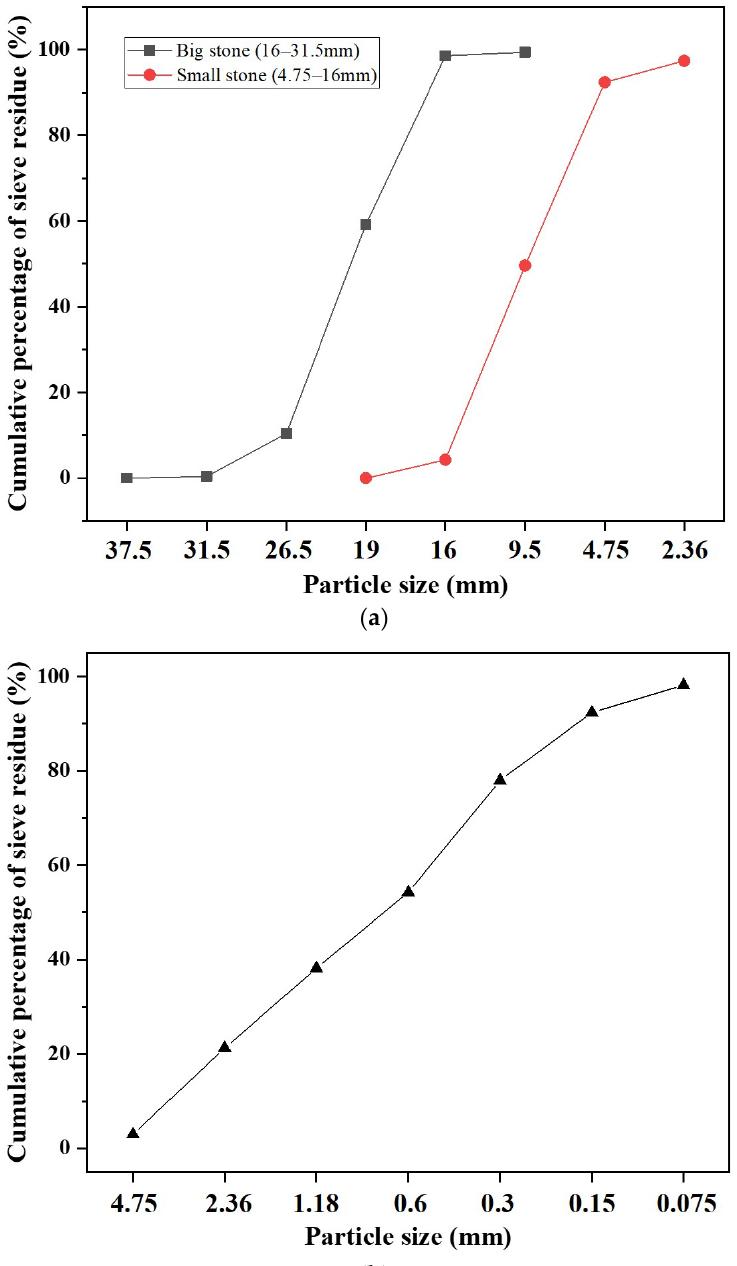
Figure 2. Particle size distribution of coarse aggregates ( a ) and fine aggregates ( b ).